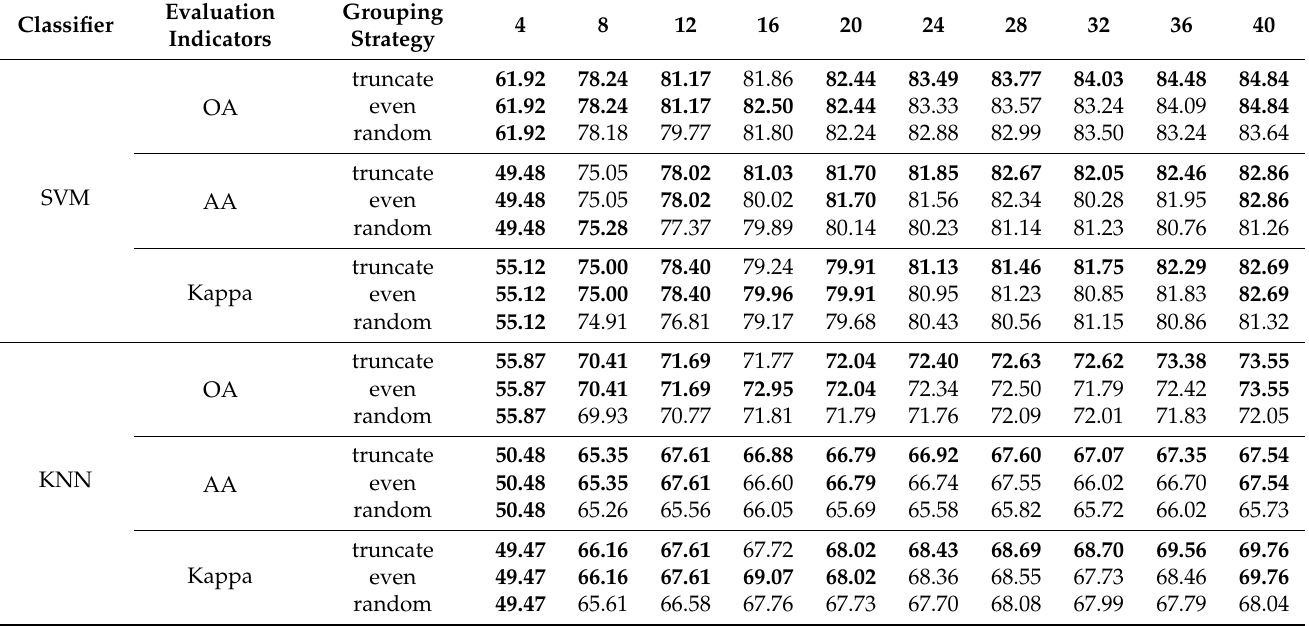
Table 3. Classification results of using different grouping strategies on the Indian Pines dataset.